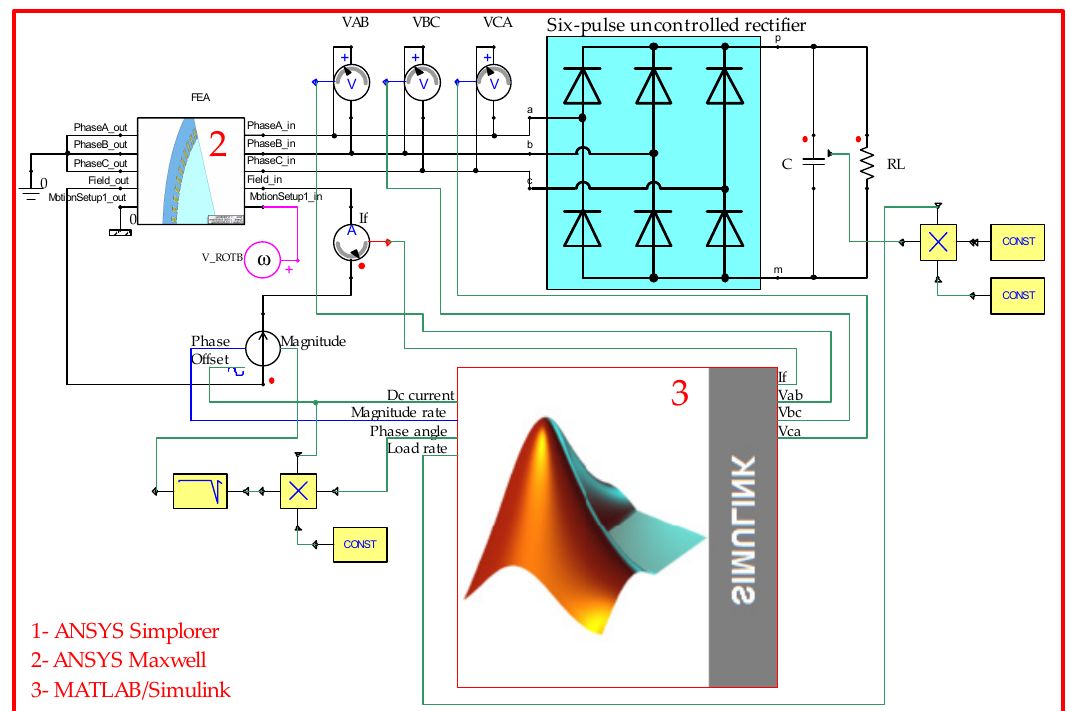
Figure 11. Test system created in ANSYS Simplorer.